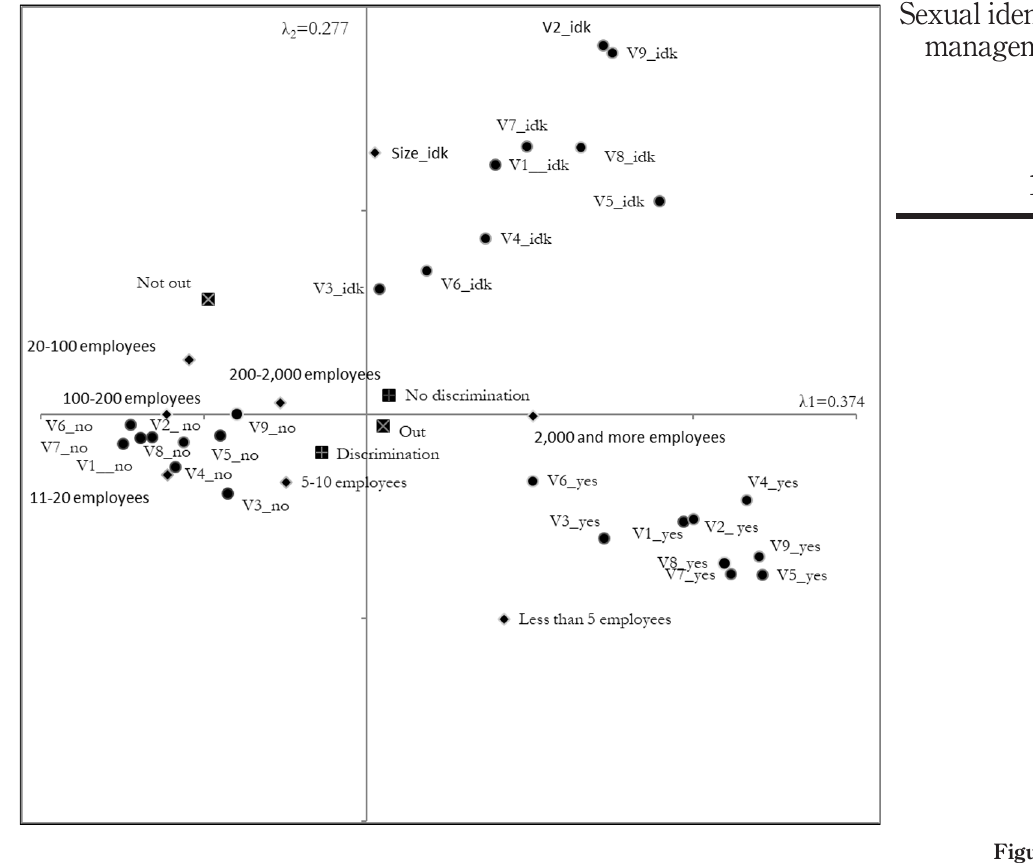
Figure 1. Company-speci fi c characteristics, discrimination and coming out in the workplace: result of a multiple correspondence